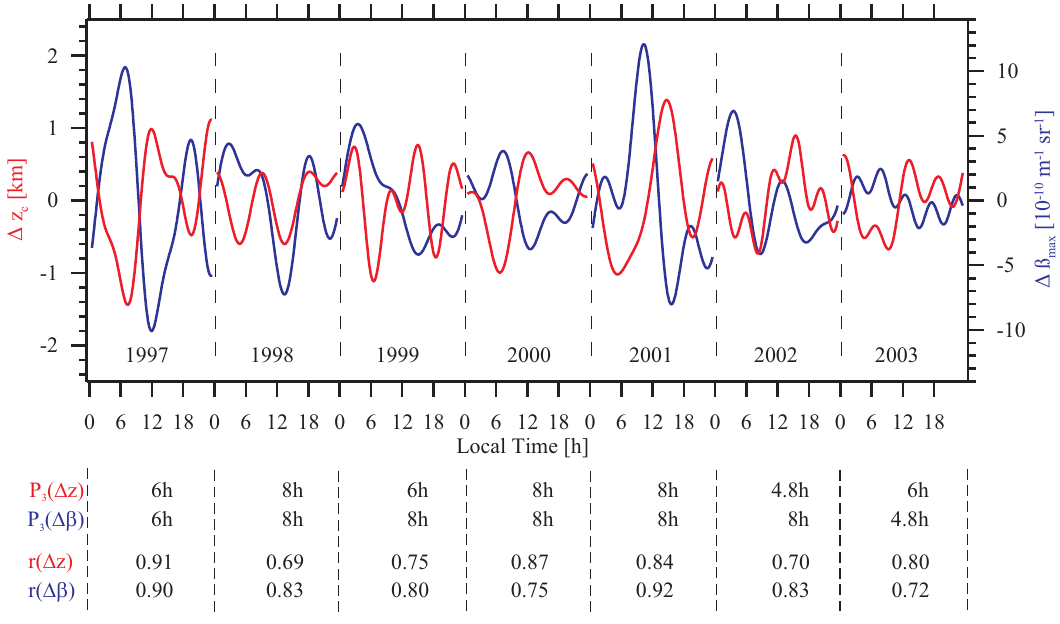
Fig. 4. Harmonic fits of the residual variations of NLC altitude (red) and brightness (blue) above ALOMAR for each individual year between 1997 and 2003. The fits to the hourly mean values are allowed for the 3 strongest oscillation periods. The third periods P 3 and the correlation coefficients r of the fits are shown at the lower